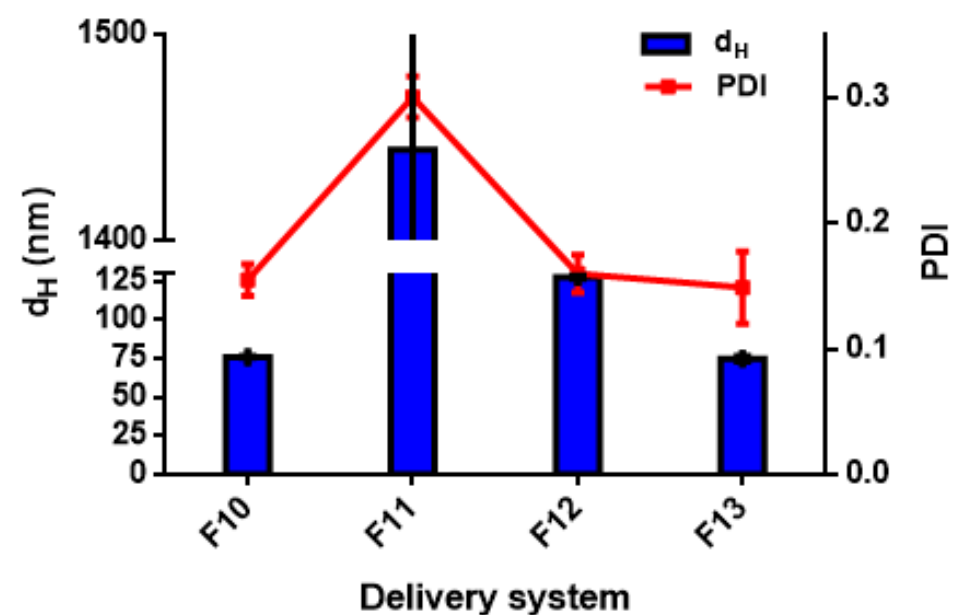
Figure 2. Hydrodynamic diameter (d H ) and polydispersity index (PDI) of TC1 EO nanoparticles (formulations F10–F13 in Table 1).